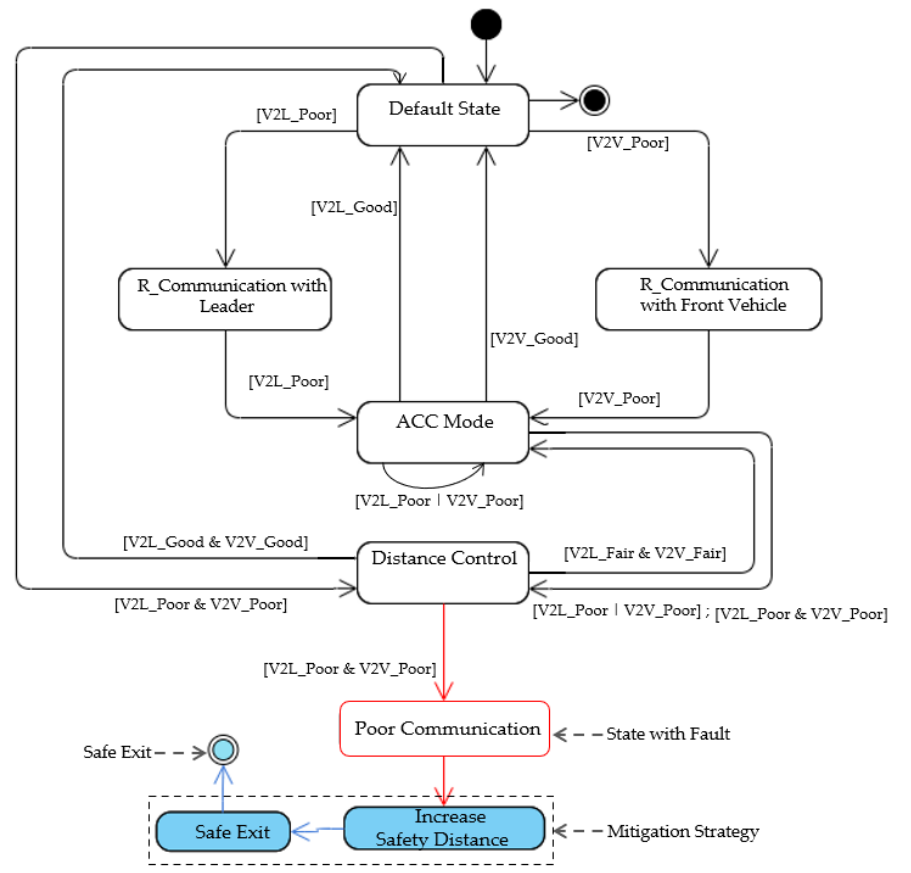
Figure 11. R-STD for communication failure.